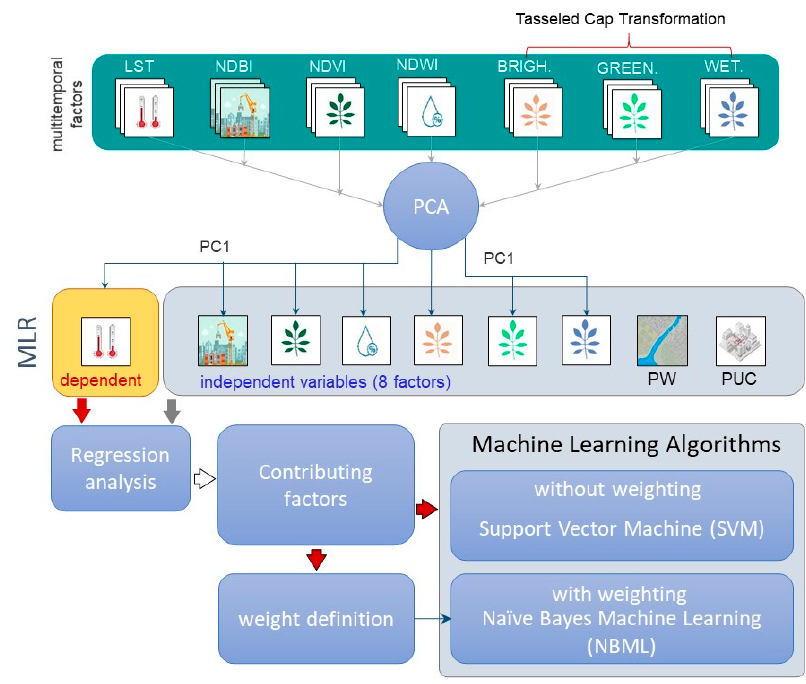
Figure 5. Flowchart of the proposed SUHI model .